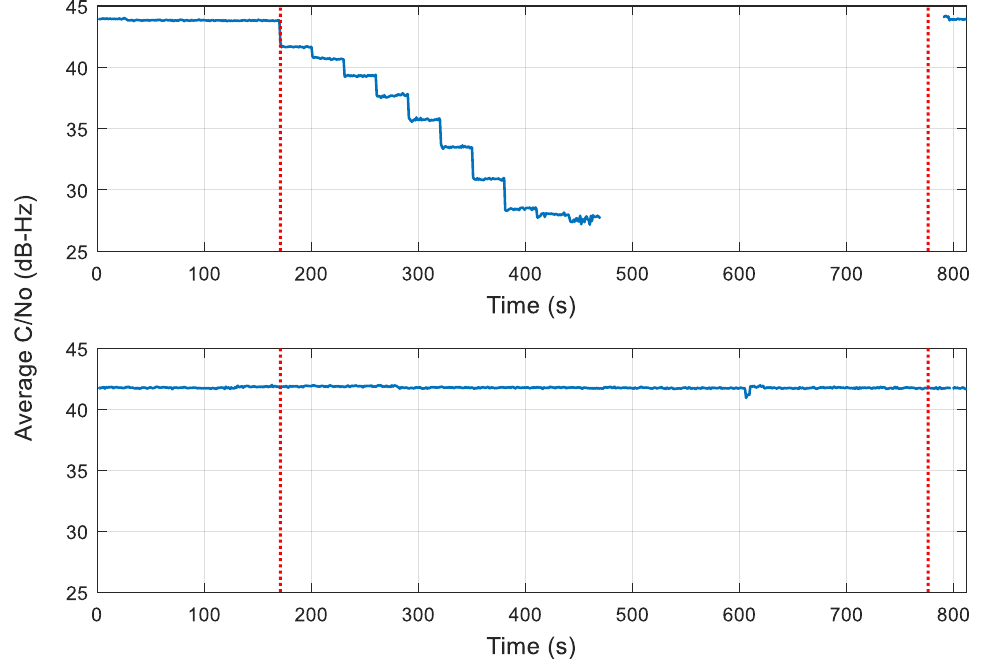
Figure 9. Average carrier-to-noise ratio of scenario #2. ( Top figure )—GPS measurements; ( bottom figure )— GLONASS measurements.